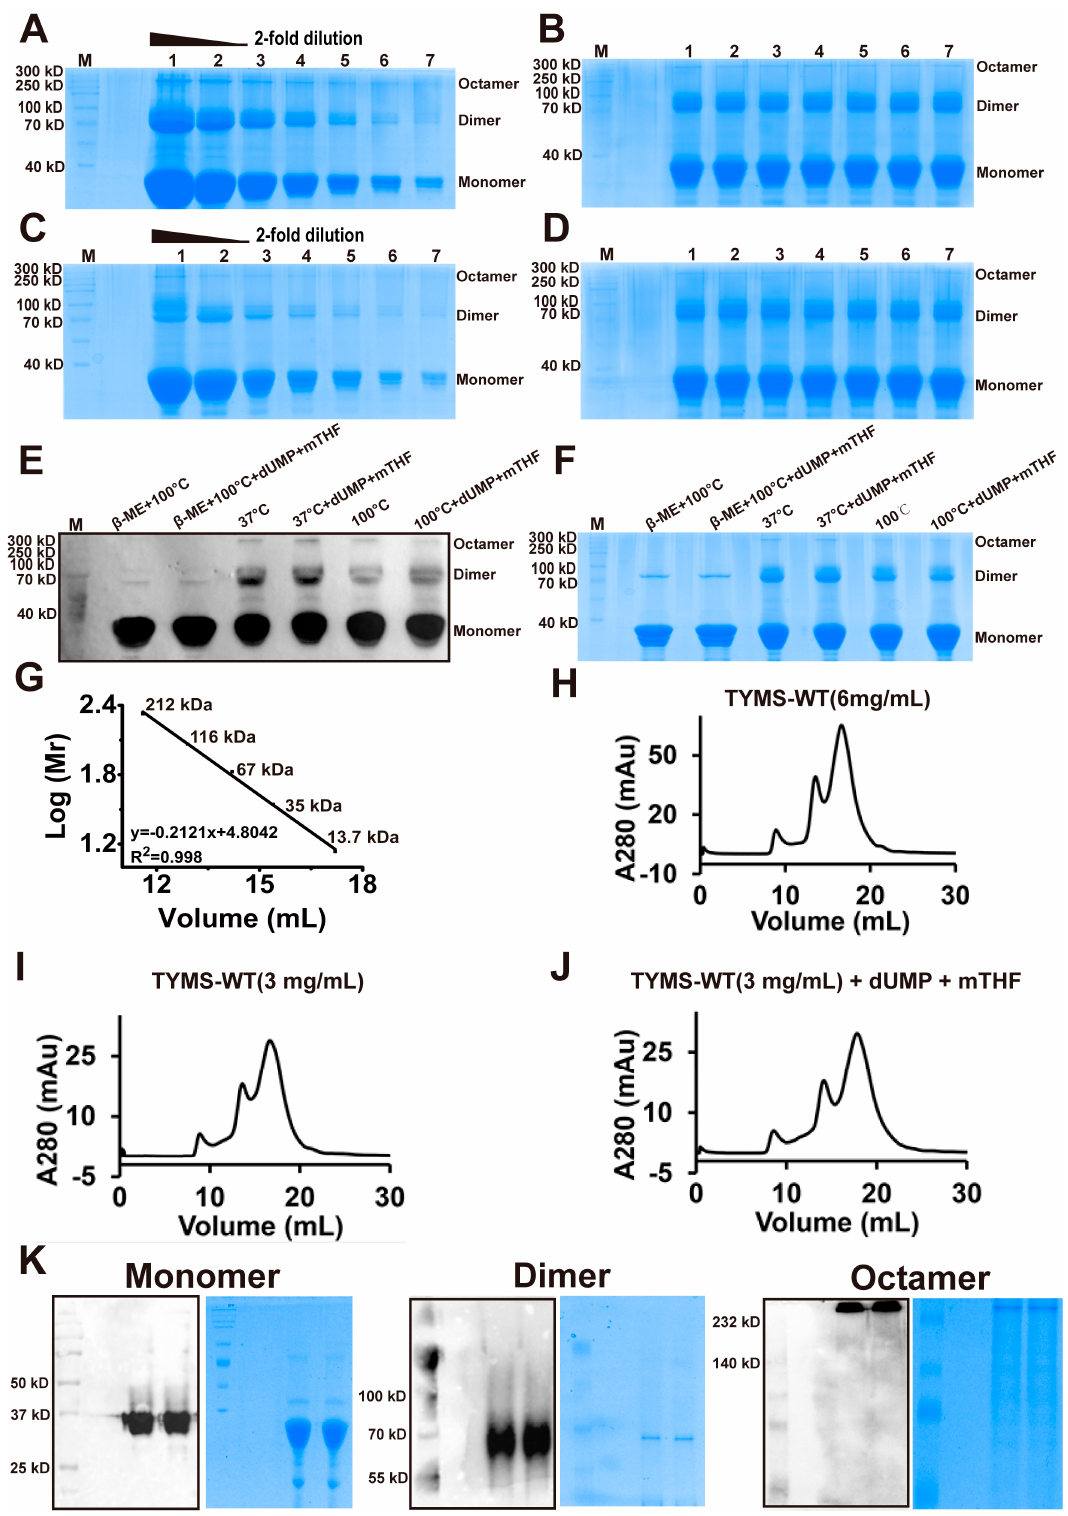
Figure 2. The determination of protein dimers and octamers. ( A ) Coomassie brilliant blue of concentrated proteins incubated without β -mercaptoethanol ( β -ME) for 10 min at 37 °C: (1) undilutedly concentrated proteins; (2) double-diluted proteins; (3) 4-times diluted proteins; (4) 8-times diluted proteins; (5) 16-times diluted proteins; (6) 32-times diluted proteins; (7) 64-times diluted proteins. The MW of monomer, dimer, and octamer are ~35 kDa, ~70 kDa, and ~280 kDa, respectively. ( B ) Coomassie brilliant blue of eight diluted proteins incubated without β -mercaptoethanol ( β -ME) for 10 min at 37 °C. ( C ) Coomassie brilliant blue of concentrated proteins incubated without β - mercaptoethanol ( β -ME) for 10 min at 100 °C: (1) undilutedly concentrated proteins; (2) double-